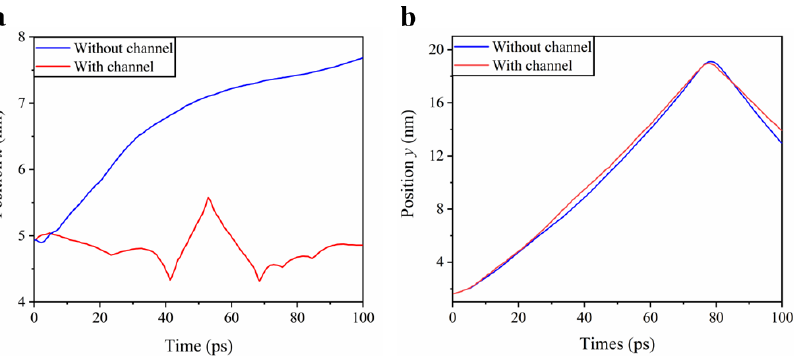
Figure 2. The evolution of the position of the centroid of graphene nanoflake. ( a ) Along x direction. ( b ) Along y